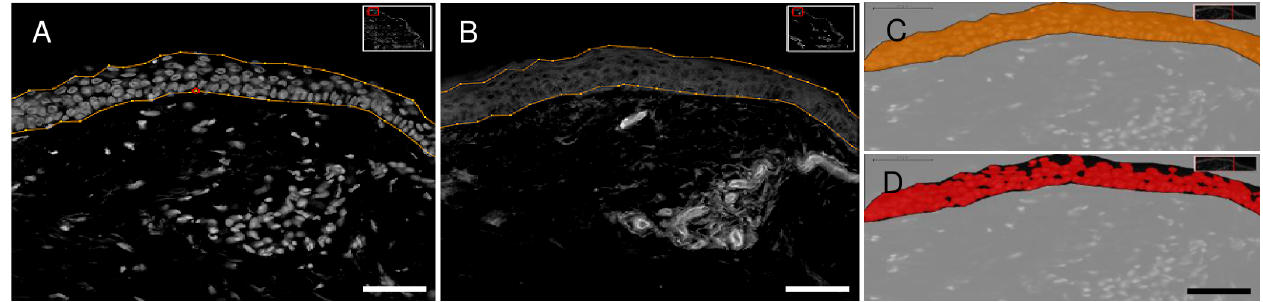
Fig 1. Definiens 1 analysis of NRP-1 expression in epidermis. (A) Selection of epidermal area using Hoechst nuclear counterstain. (B) Selected epidermal area shown in NRP-1 layer. (C) Total epidermal area in orange. (D) NRP-1 positive marker area as recognized by software in red. Scale bar: 50 μ